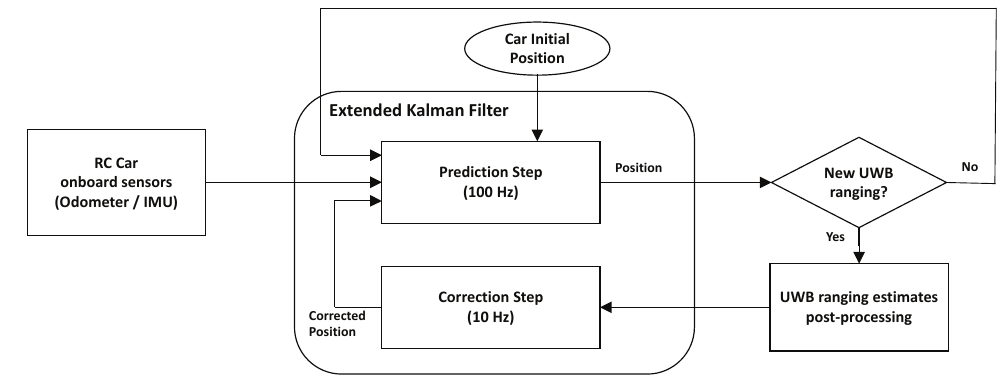
Figure 2. Architecture of the positioning system